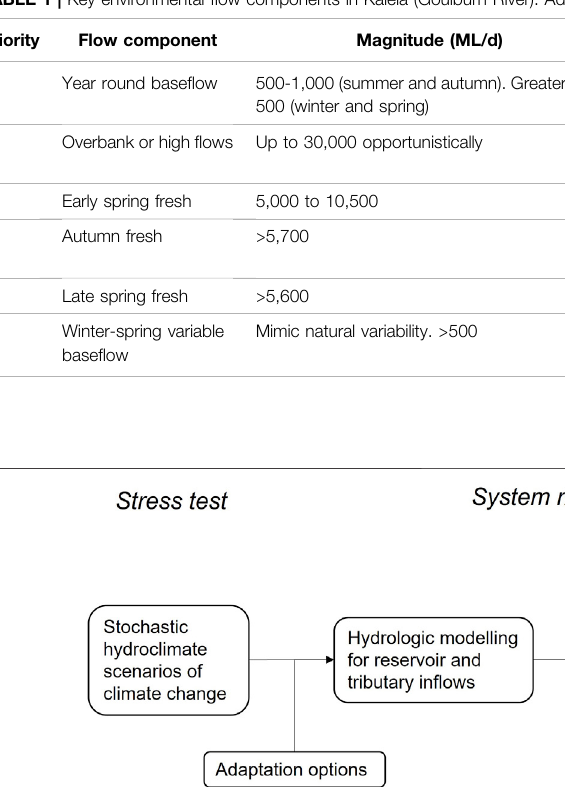
TABLE 1 | Key environmental fl ow components in Kaiela (Goulburn River). Adapted from Horne et al. (2020).